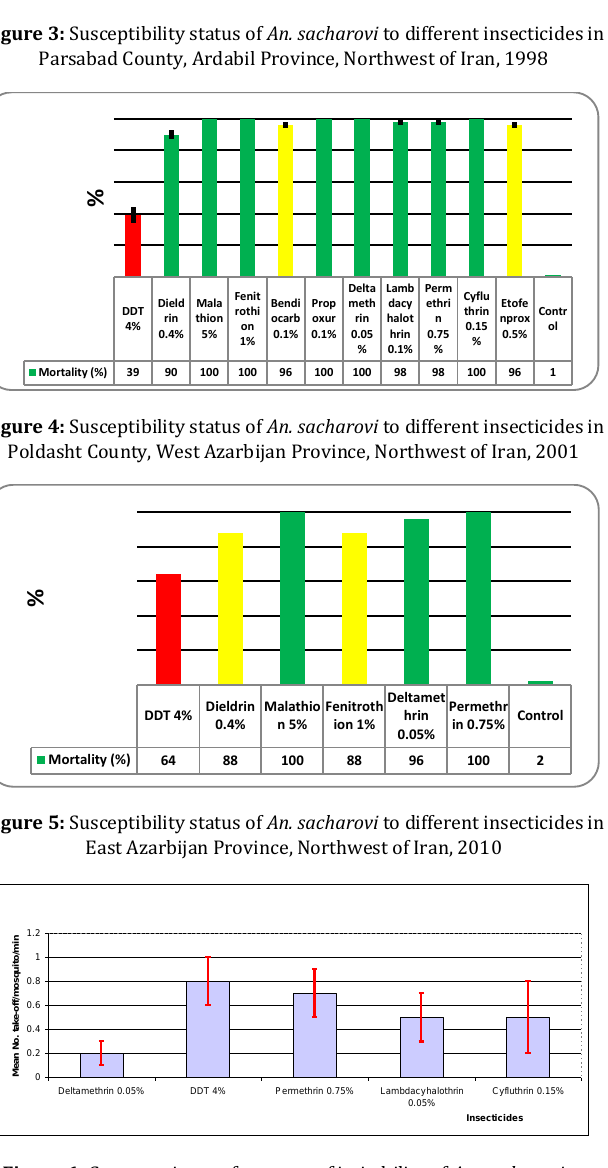
Figure 6: Comparative performance of irritability of An. sacharovi to different insecticides, East Azarbijan, Northwest of Iran, 2010